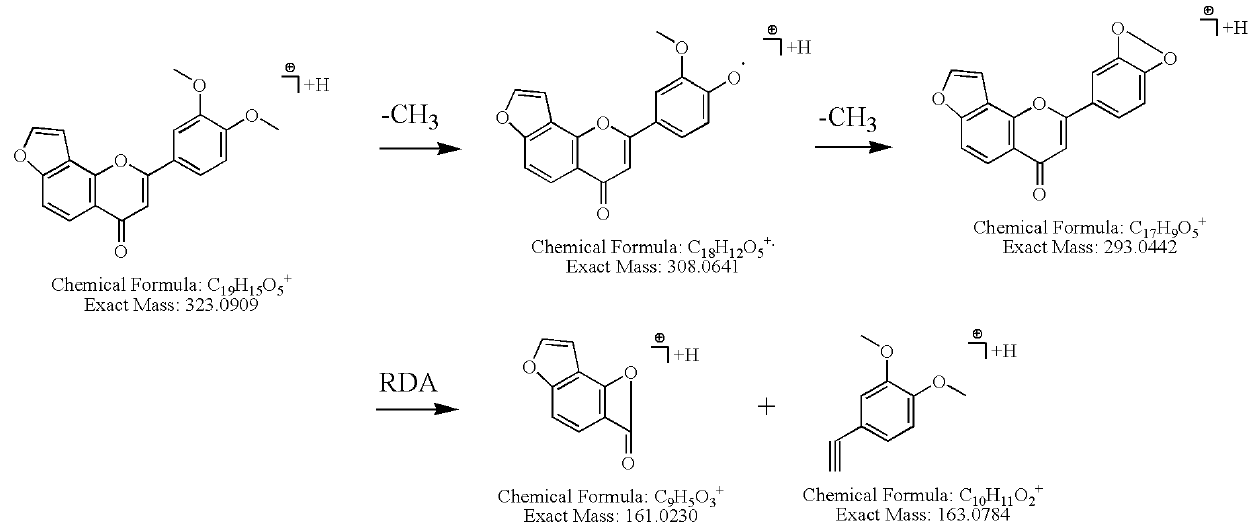
H O , [M+H-CH ] + ) and m/z 17 10 5 3